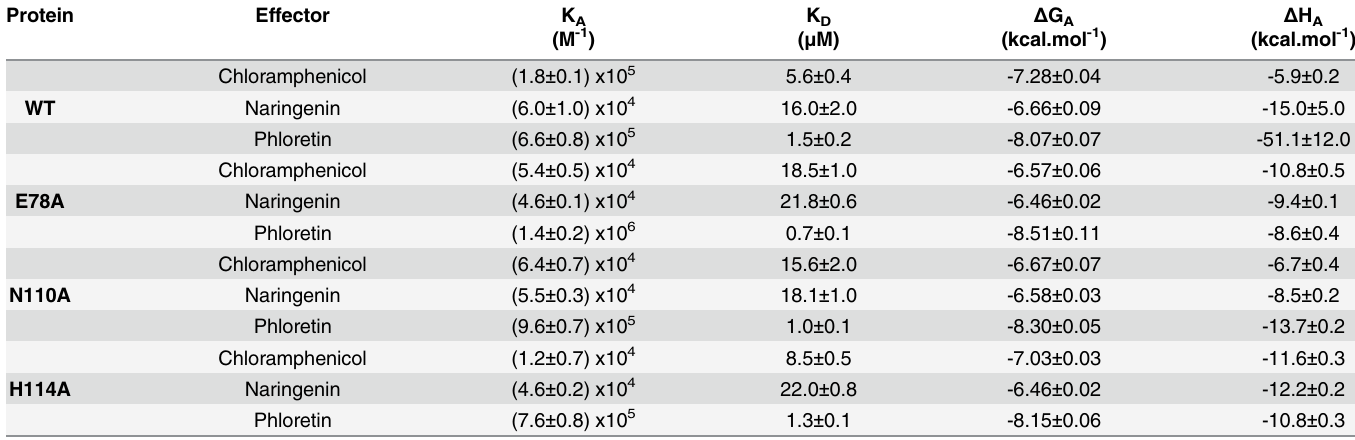
Table 4. Thermodynamic parameters of the association of TtgR and mutants with chloramphenicol, naringenin and phloretin. Protein